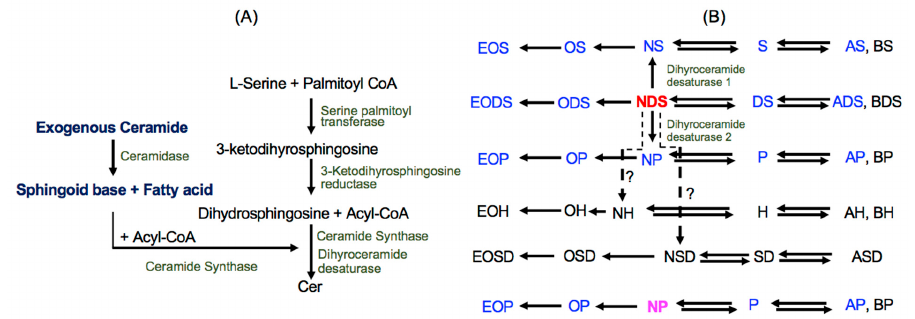
Figure 1. Cer synthetic pathway and fates of exogenous NDS and NP. ( A ) Ceramide synthetic pathway, ( B ) Fates of NDS and NP. Abbreviations for nomenclature of Cer species are according to [2,11,25] with some modifications. Non-hydroxy acyl sphingosine (NS); Non-hydroxy acyl 4-hy- droxydihydrosphingosine (NP); Non-hydroxy acyl dihydrosphingosine (NDS); Non-hydroxy acyl 6-hydroxydsphingosine (NH); Non-hydroxy acyl 4,14-sphingadiene (NSD); 2-hydroxy acyl sphin- gosine (AS); 2-hydroxy acyl 4-hydroxydihydrosphingosine (AP); 2-hydroxy acyl dihydrosphingo- sine (ADS); 2-hydroxy acyl 6-hydroxy sphingosine (AH); 2-hydroxy acyl 4,14-sphingadiene (ASD); ß-hydroxy acyl sphingosine (BS); ω -hydroxy-N-non-hydroxy acyl sphingosine (OS); ω -hydroxy-N- non-hydroxy acyl 4-hydroxydihydrosphingosine (OP); ω -hydroxy-N-non-hydroxy acyl dihydro- sphingosine (ODS), ω -hydroxy-N-non-hydroxy acyl 6-hydroxydsphingosine (OH); ω -hydroxy-N- non-hydroxy acyl 4,14-sphingadiene (OSD); ω -O-acyl-N-non-hydroxy acyl sphingosine (EOS); ω - O-acyl-N-non-hydroxy acyl 4-hydroxydihydrosphingosine (EOP); ω -O-acyl-N-non-hydroxy acyl dihydrosphingosine (EODS), ω -O-acyl-N-non-hydroxy acyl 6-hydroxydsphingosine (EOH); ω -O- acyl-N-non-hydroxy acyl 4,14-sphingadiene (EOSD). Cer species confirmed in current study are in blue. Cer in black letters is not analyzed.